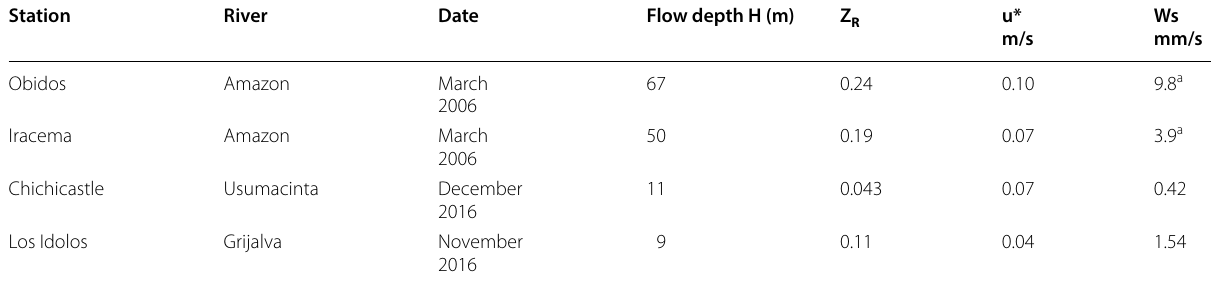
Table 4 Comparison of measured values in the Amazon river with this research results Station